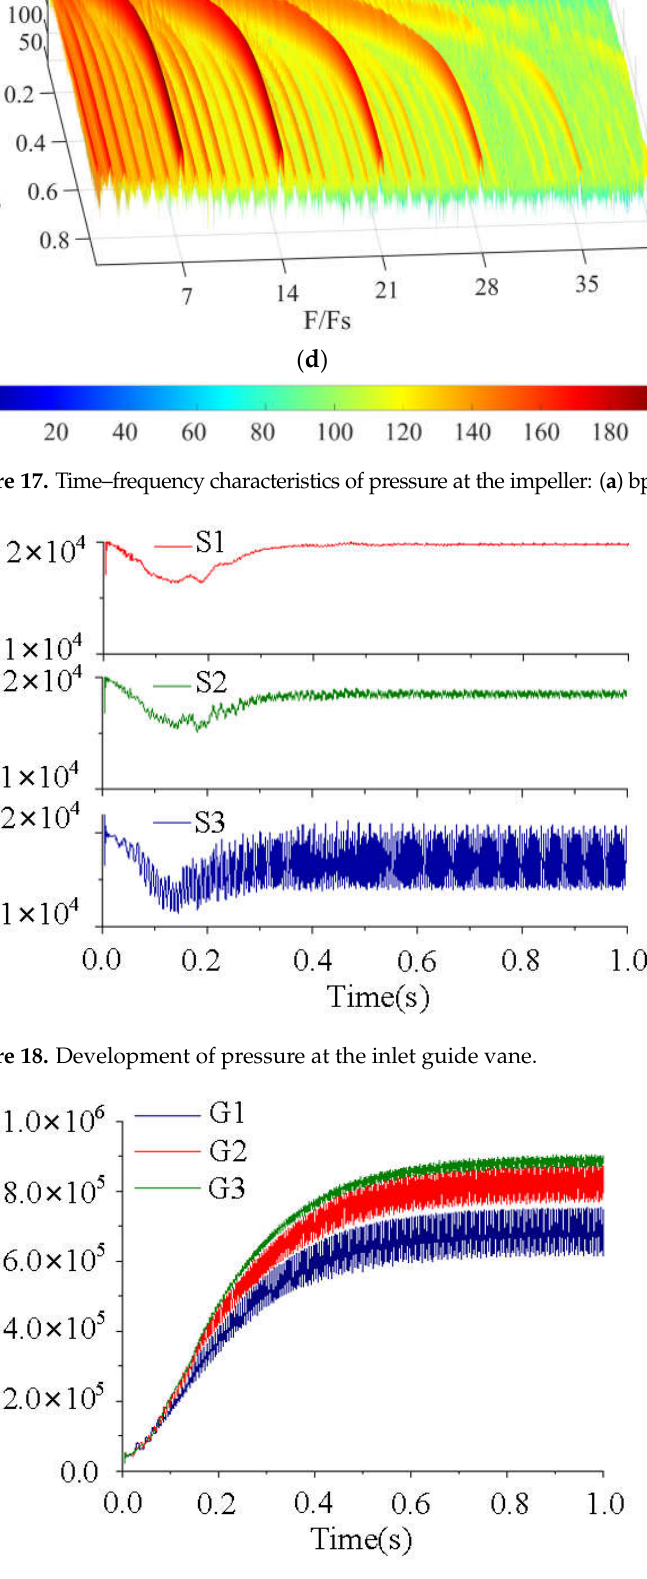
Figure 19. Development of pressure at the diffuser.